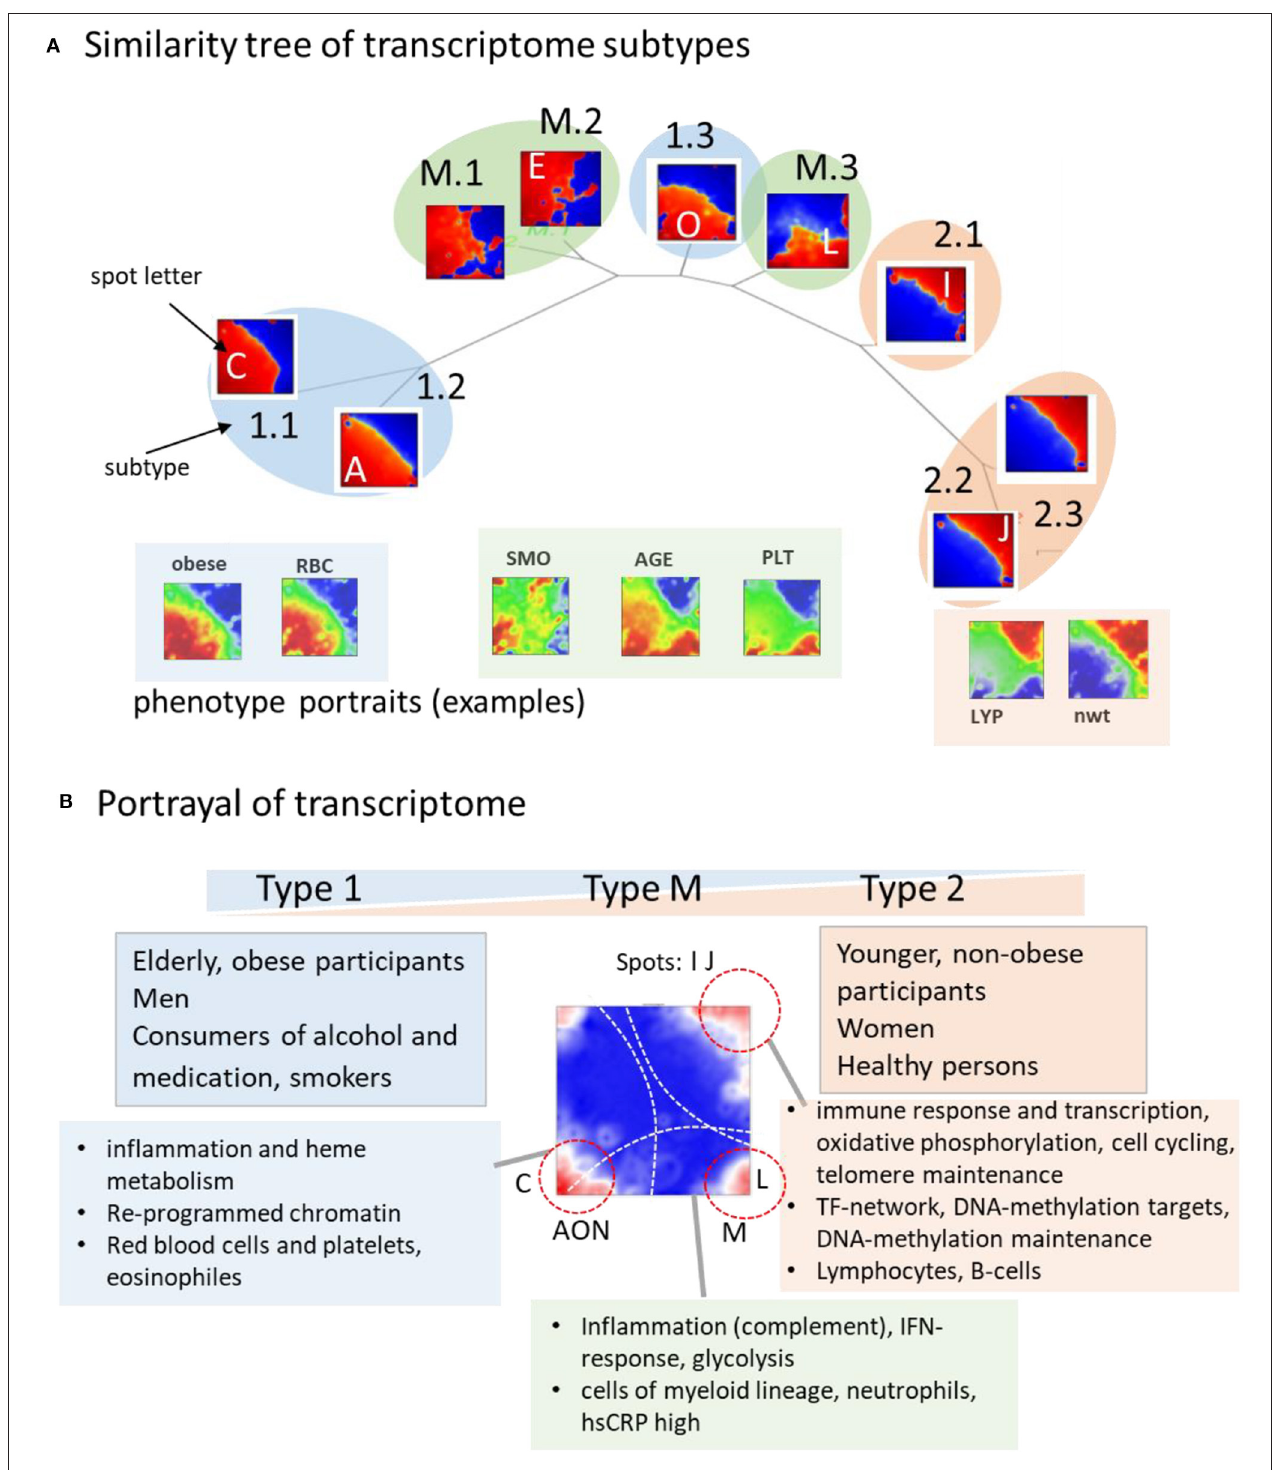
FIGURE 7 | Portrayal of the blood transcriptome: (A) The similarity tree reflects a virtually linear arrangement of subtypes due to a continuum of transcriptional states ranging from type 1 to type 2. Selected phenotype portraits illustrate correlation of the respective features with the transcriptomes of different types. (B) Main functions and phenotypes associating with the transcriptome